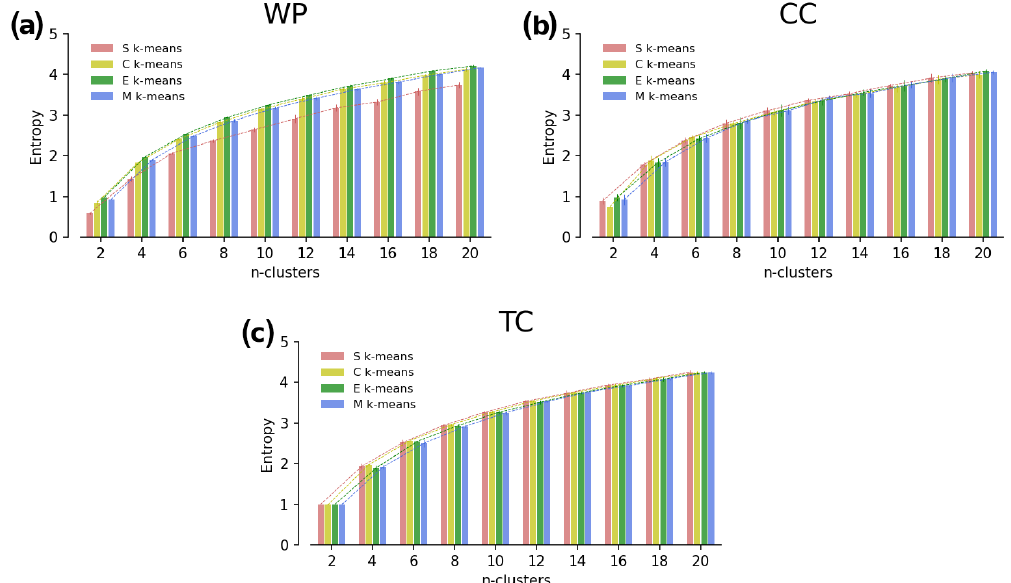
Figure 7. Shannon entropy of clustering results. Comparison of the average silhouette score (S score) of S, C, E, and M k -means for k = 2, 4, ..., 20 for three demonstration experiments: WP (a) , CC (b) , and TC (c) . The uncertainty range in each line indicates the standard deviations of the scores among 10 runs with randomized initializations.